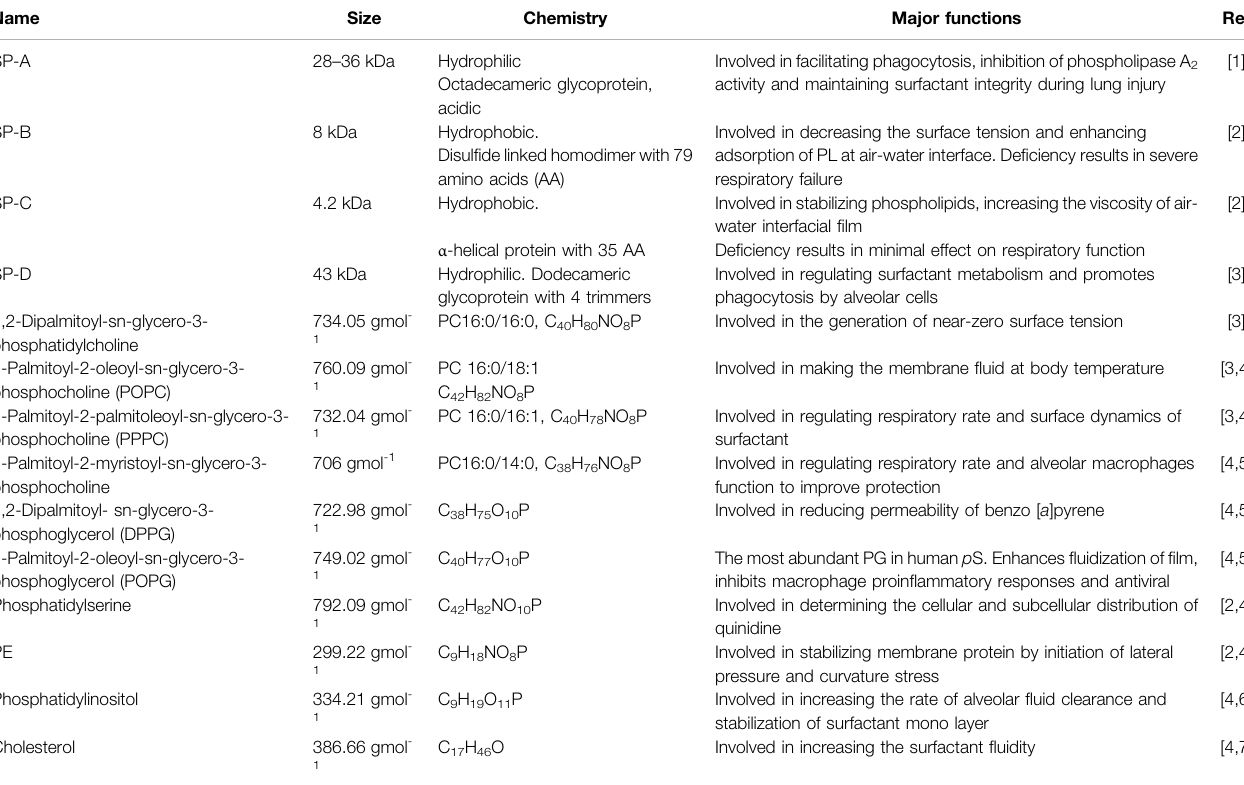
TABLE 1 | Characteristics and details of pulmonary surfactant proteins and surfactant